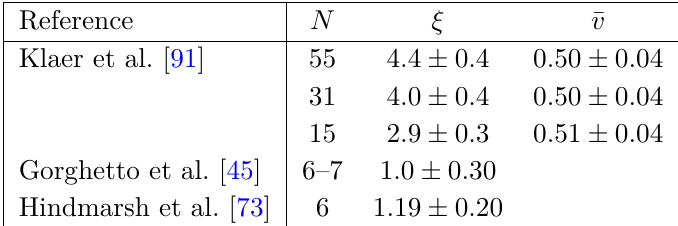
Table 1 . Results from recent global string network simulations (in a radiation dominated back- ground) for the number of strings per Hubble volume ξ and the average velocity of long strings ¯ v in radiation dominated background. These data points were also applied in [81]. In the main text, we explain why some other recent simulation results were left out of this table (thus our analysis) and their